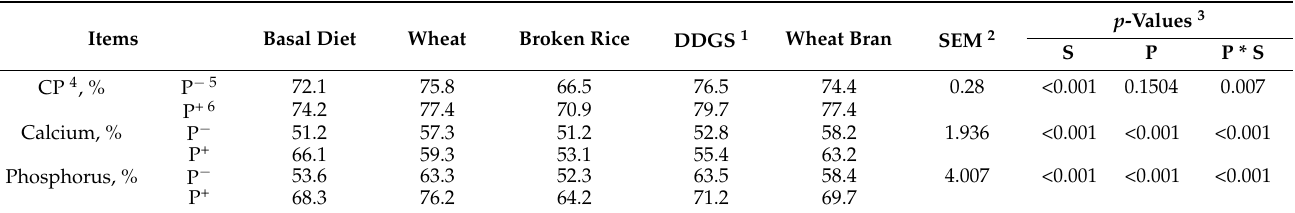
Table 7. Effect of diet supplementary with phytase on apparent total tract digestibility of CP and calcium and phosphorus in